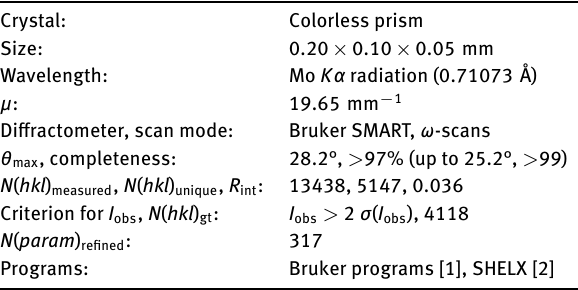
Table 1: Data collection and